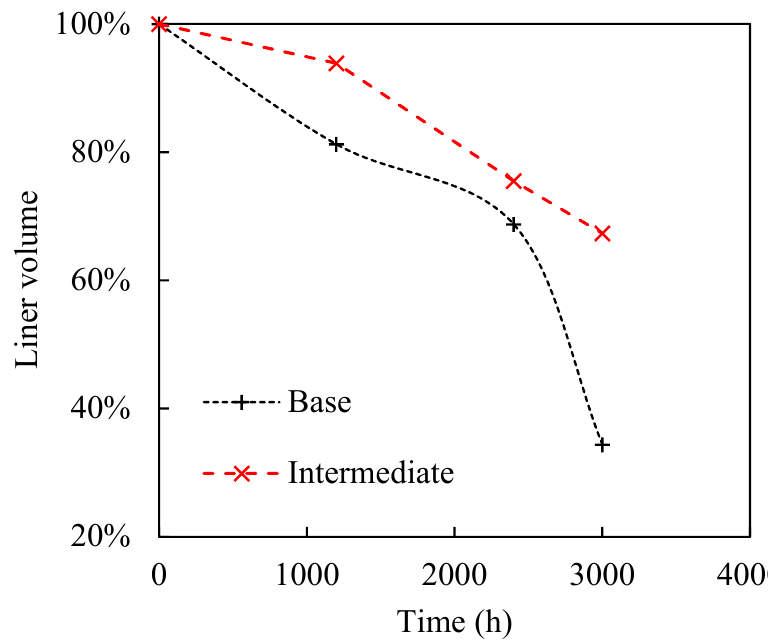
Figure 19. Base and intermediate liner volume reduction during liner operational time (in hours).